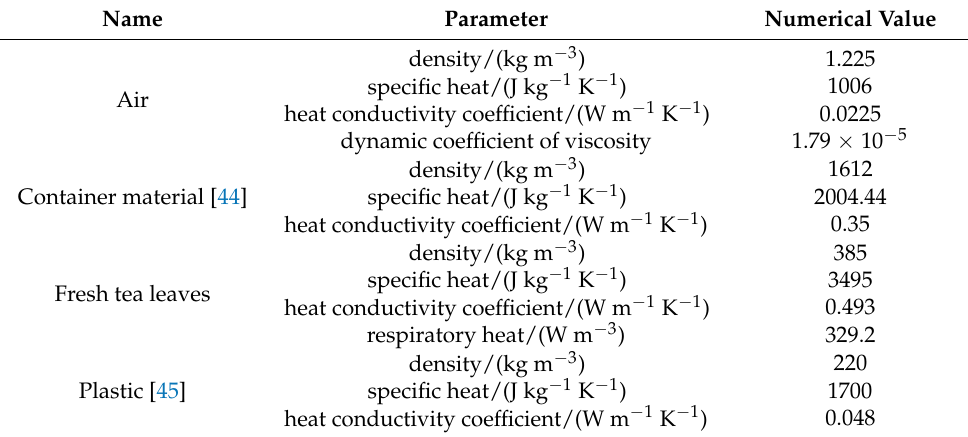
Table 1. Setting of physical